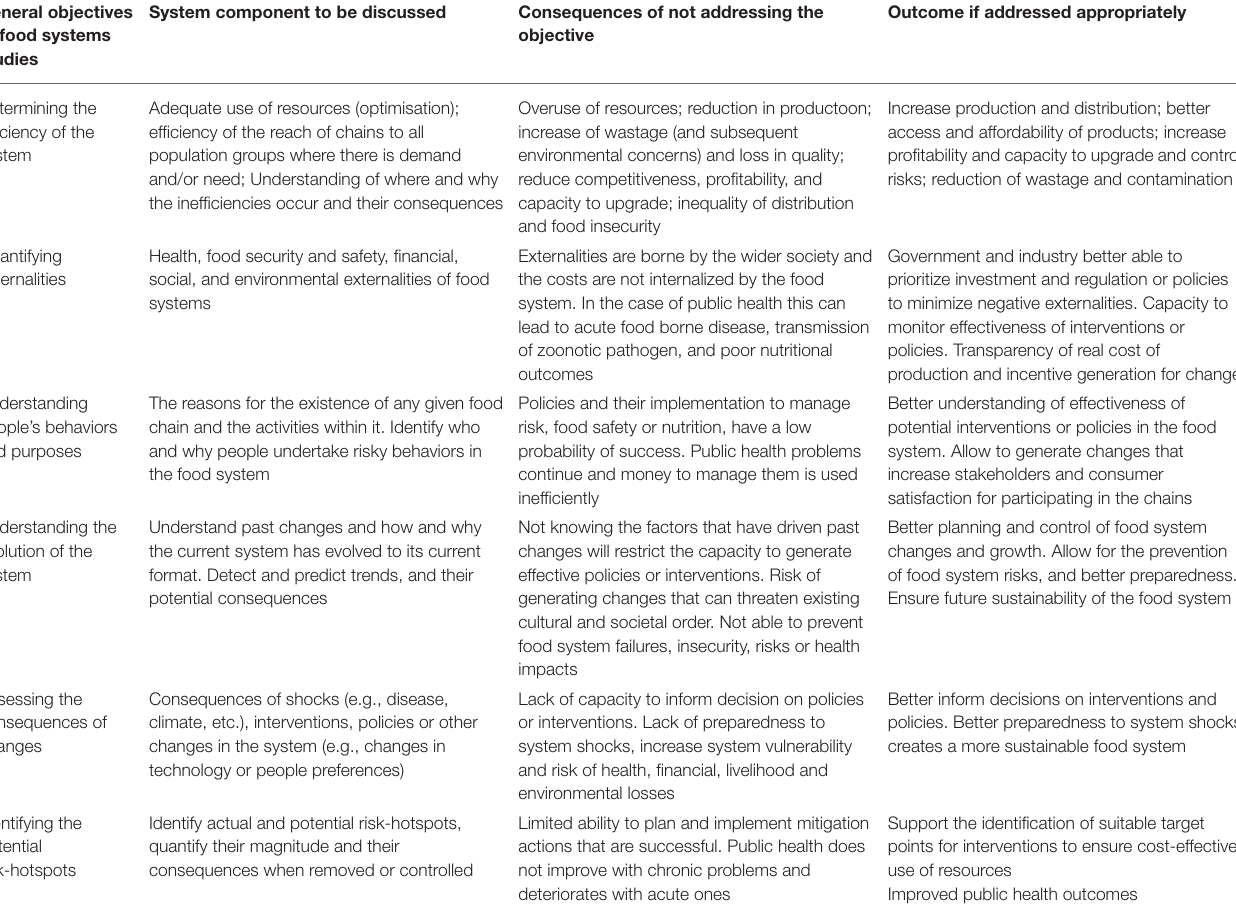
TABLE 1 | General objectives of food systems studies, and the consequences of meeting or not meeting these objectives. General objectives of food